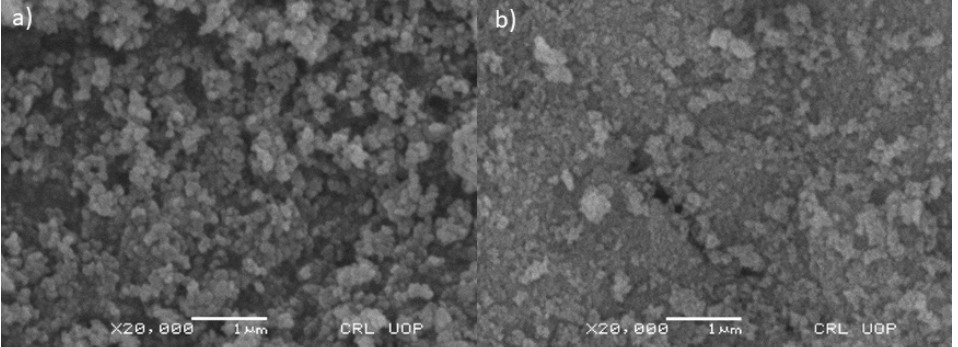
Figure 2. FT-IR spectra of ( a ) Fe 3 O 4 and ( b ) Fe 3 O 4 @SiO 2 @APTES.